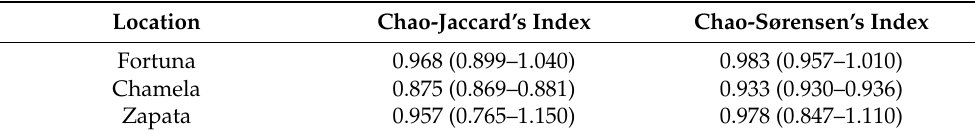
Table 3. Bat species composition similarity by location between two post-hurricane years (2016 vs. 2017) and CI (95%).